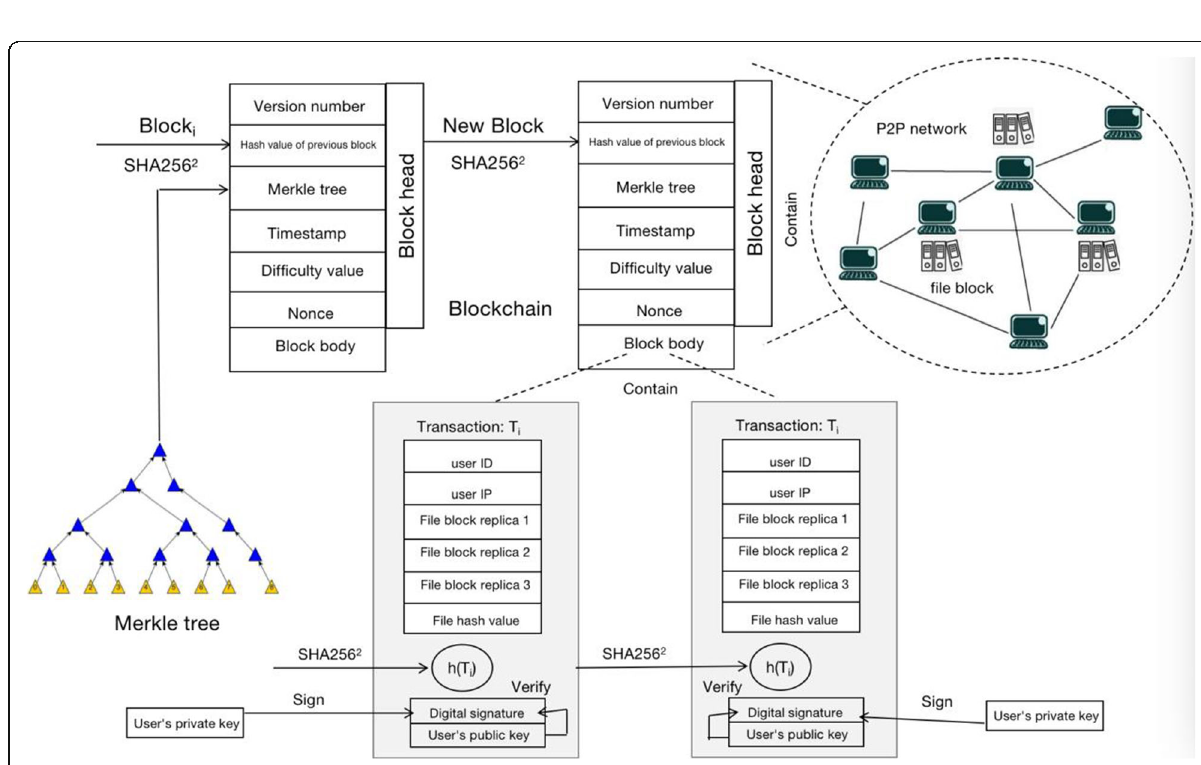
Fig. 18 Blockchain-based distributed cloud data storage architecture